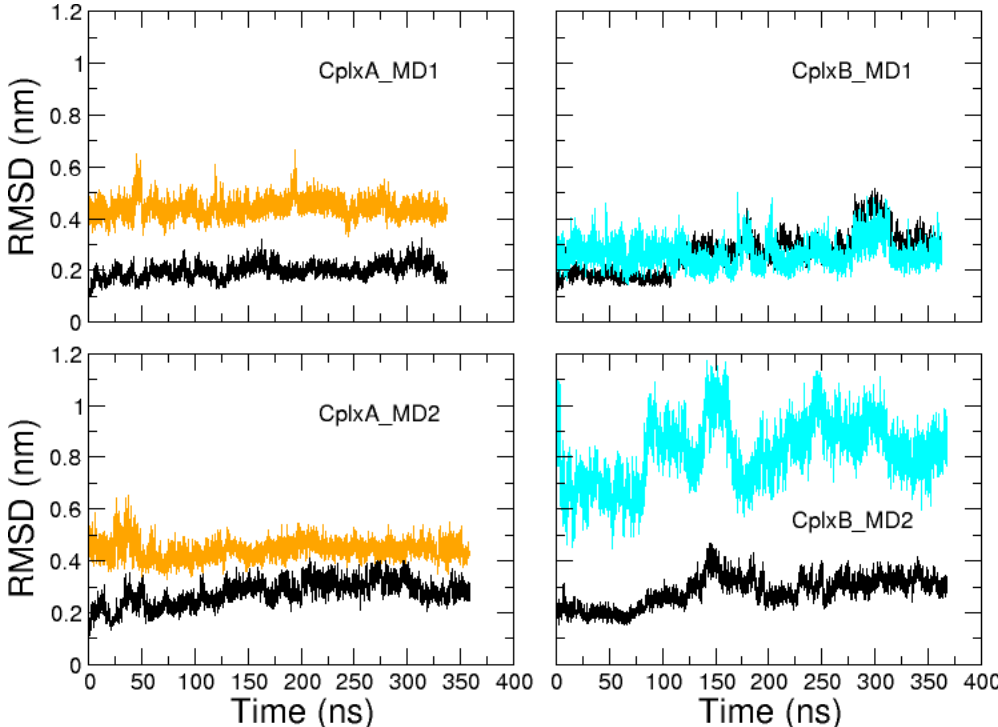
Figure 4. Time evolutions of RMSD relative to structure 2VCP, after fitting MD trajectories on crystallographic actin, for actin (black) and segments 9–18 (orange) and 37–46 (cyan) of N-WASP domain